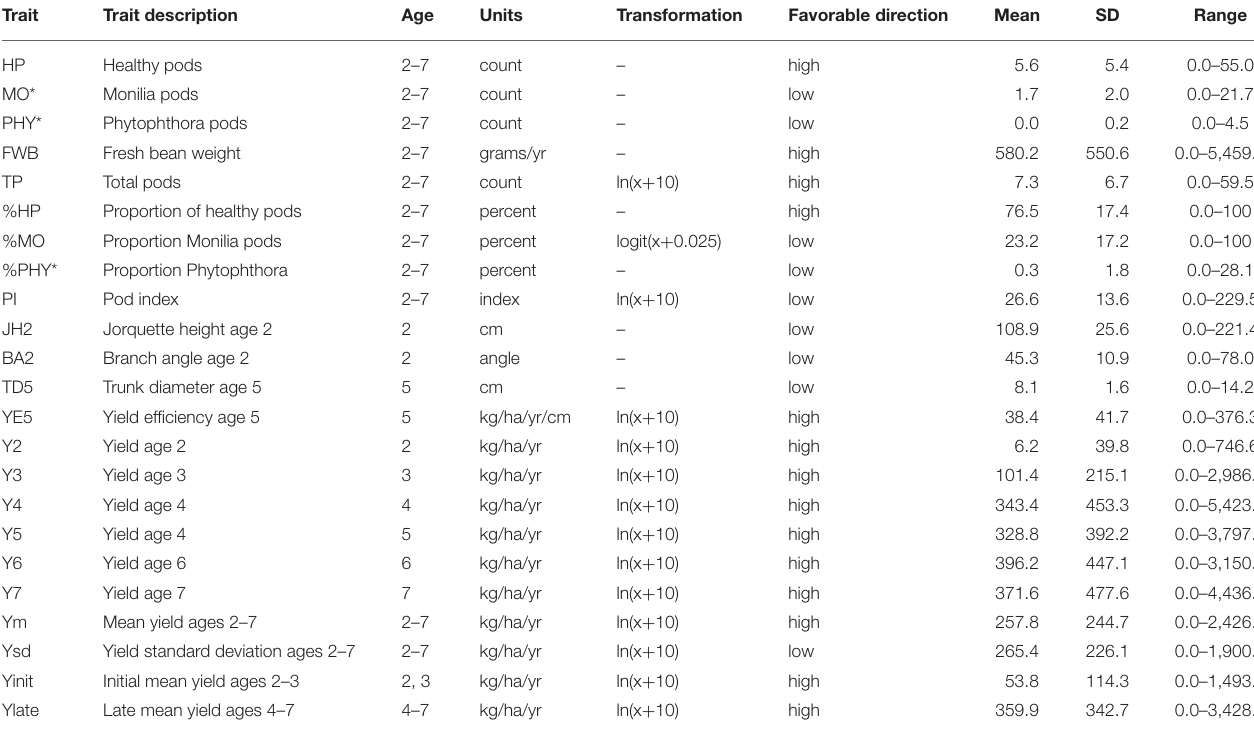
TABLE 1 | Description and summary statistics of available traits from the L7 population established in Costa Rica (10 ◦ 06 ′ latitude N, 83 ◦ 23 ′ longitude W, 40m a.s.l) in mid-2003 at CATIE’s “La Lola” experimental farm.